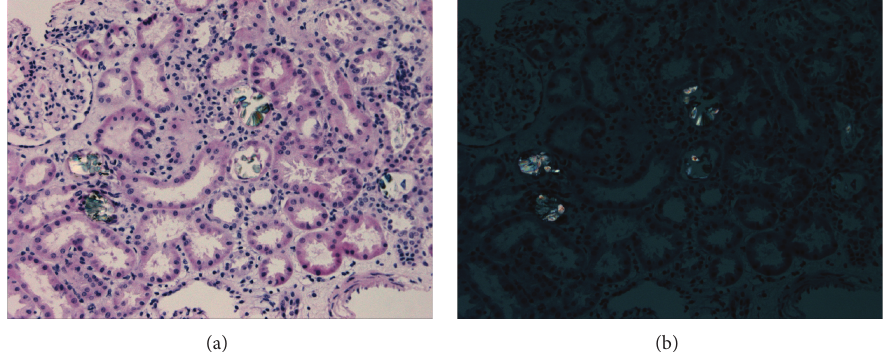
Figure 1: (a) Tubules packed with oxalate crystals. H&E staining, 20x magnification. (b) Birefringent oxalate crystals. H&E staining, 20x magnification, using polarized